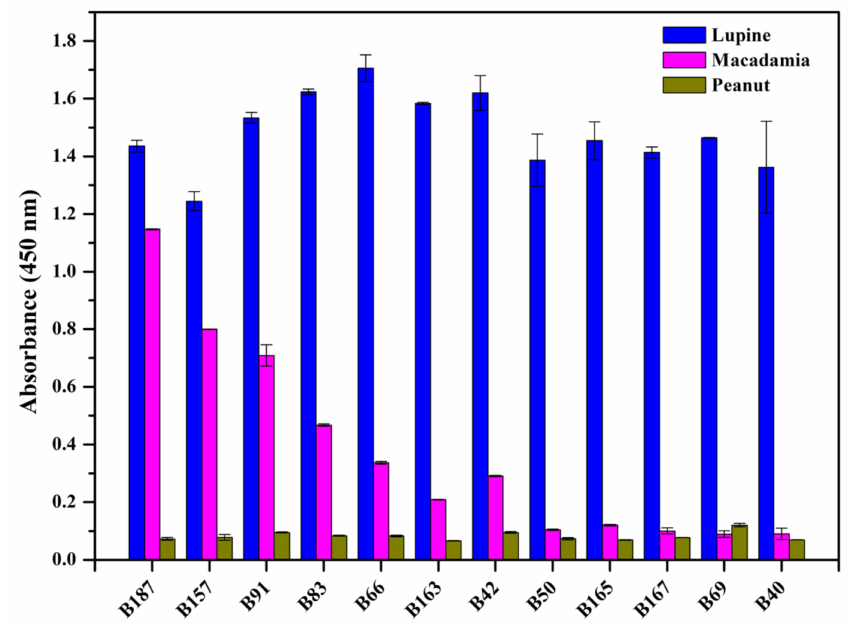
Figure 4. Cross-reactivity of selected Nbs. The cross-reaction with other antigens from macadamia and peanut has been determined by